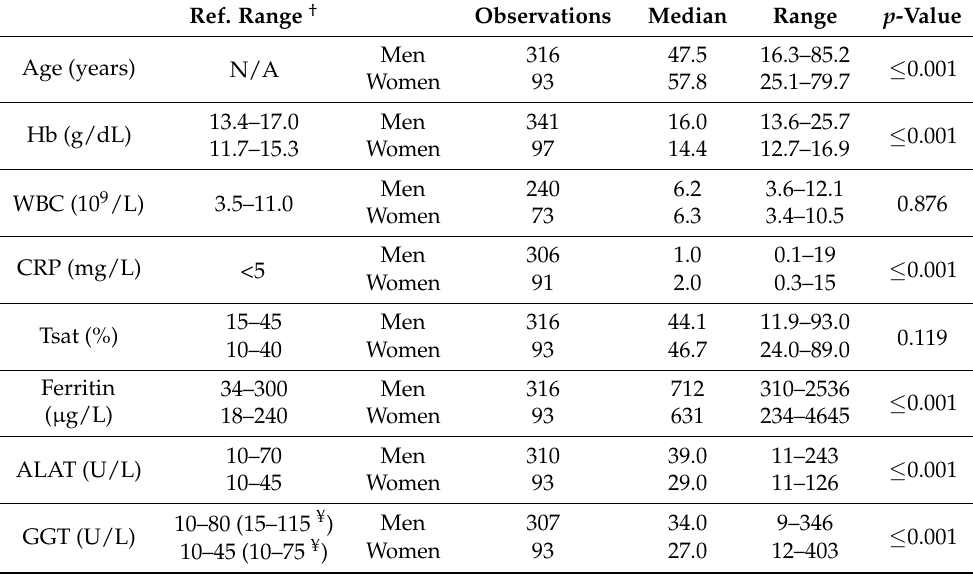
Table 1. Descriptive statistics for patients included in the study.